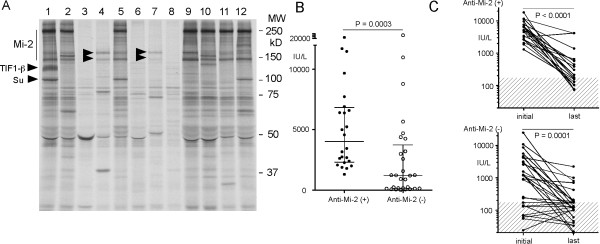
Autoantibodies by immunoprecipitation and CPK levels in Mexican patients with PM/DM. A. Immunoprecipitation using sera from Mexican patients with PM/DM. 35S-methionine labeled K562 cell extract was immunoprecipitated using sera from PM/DM patients. Molecular weight markers and positions of Mi-2, TIF-1β, Su and p155/140 (arrowheads) are indicated. B. CPK levels at initial visit are significantly higher in anti-Mi-2 (+) than anti-Mi-2 (-) DM patients. CPK levels of DM patients at initial visit are plotted. Lines in each group indicate median + interquartile range. P = 0.0003 by Mann-Whitney. C. CPK levels at initial and last visit in each DM patient compared between anti-Mi-2 (+) and (-) groups. Top, anti-Mi-2 (+) group, initial versus last visit, P < 0.0001 by Wilcoxon matched pairs test. CPK, creatine phosphokinase; PM/DM, polymyositis/dermatomyositis.